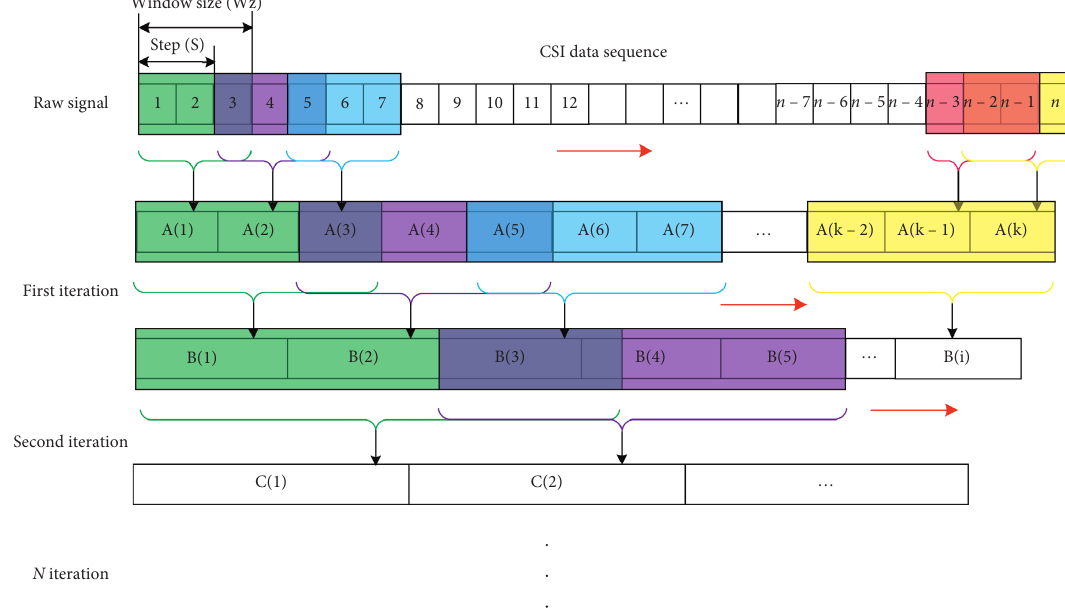
Figure 6: The iterative structure of the sliding